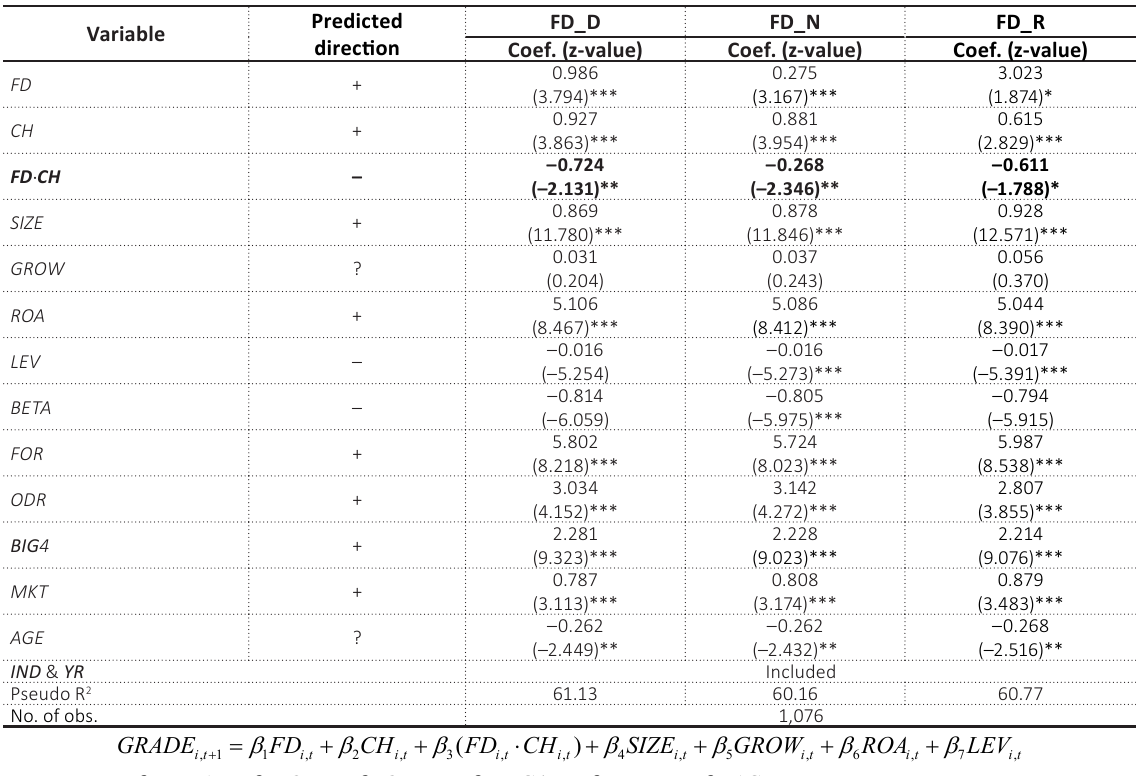
Table 4. Moderating effect of chaebol enterprises in the relationship between female directors and credit ratings ( H2